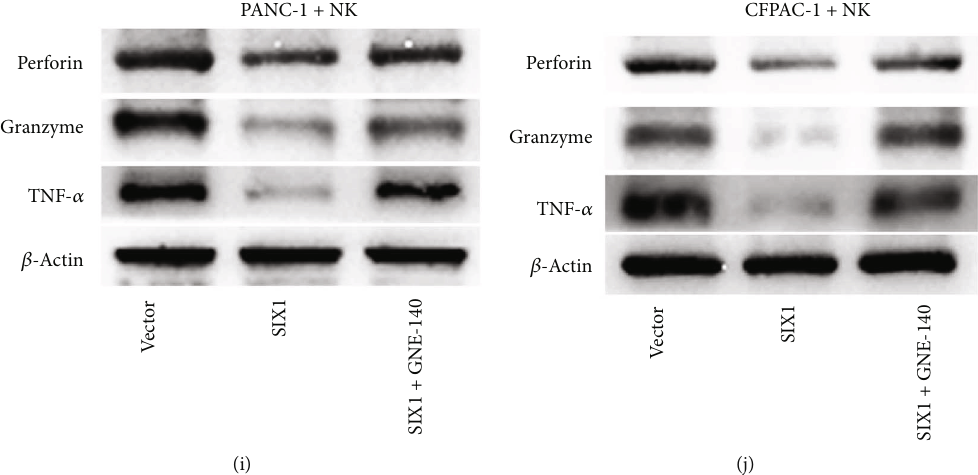
Figure 7: LDHA can partially restore the e ff ects of SIX1 in PC. (a – f) Glucose consumption, lactate production, and ATP levels were measured to analyze glycolysis in SIX1-overexpressing cells treated with an LDHA inhibitor. (g, h) The percentages of NKP46- and NKG2D-positive NK cells cocultured with SIX1-overexpressing PC cells treated with GNE-140. (i, j) Expression of perforin, granzyme B, and TNF- α in NK cells cocultured with SIX1-overexpressing PC cells treated with GNE-140 as indicated by western blotting; β -actin served as the internal control. The data are presented as the mean ± SD from three independent experiments. ∗ P ≤ 0 : 05 , ∗∗ P ≤ 0 : 01 , and ∗∗∗ P ≤ 0 : 001